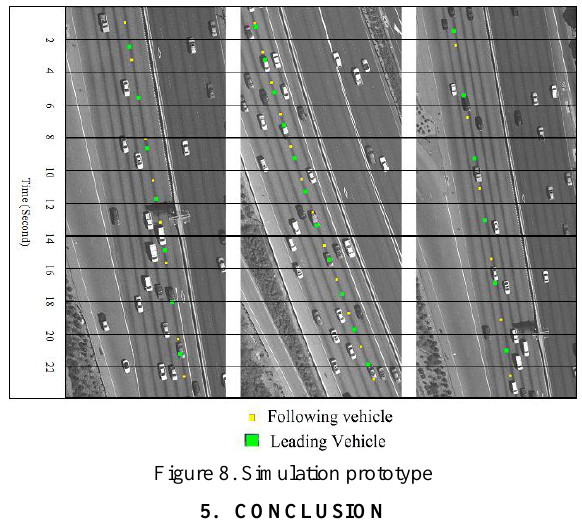
Figure 8. Simulation